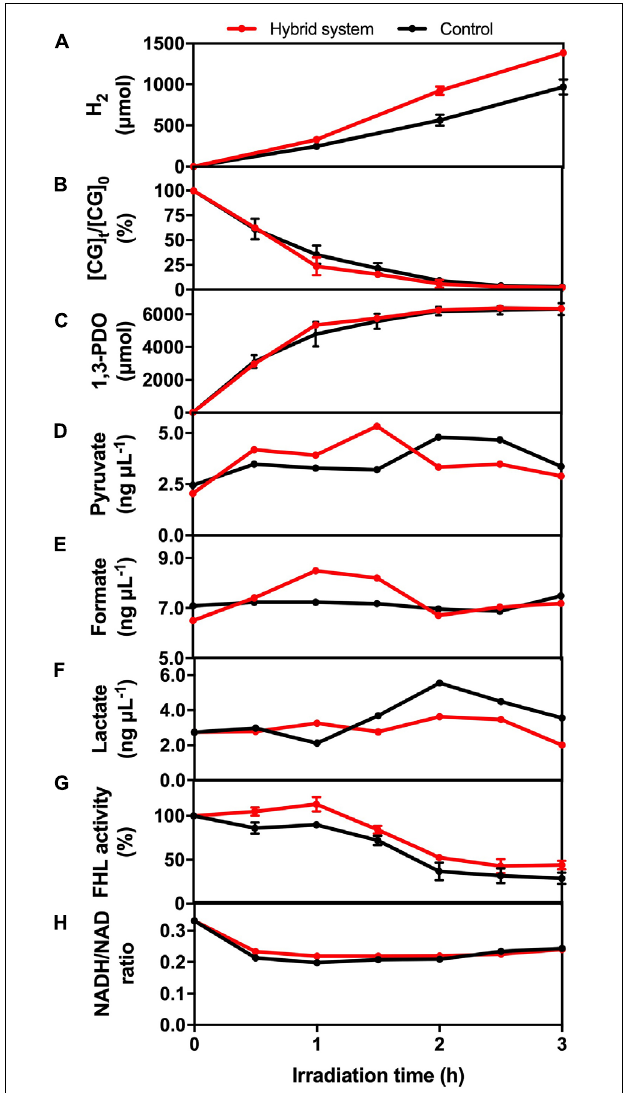
FIGURE 8 | (A) H 2 production, (B) CG utilization, (C) 1,3-PDO production, (D) pyruvate concentration, (E) formate concentration, (F) lactate concentration, (G) formate hydrogen lyase (FHL) activity, and (H) NADH/NAD ratio of the hybrid system under VL irradiation (2,000 W m − 2 ) and